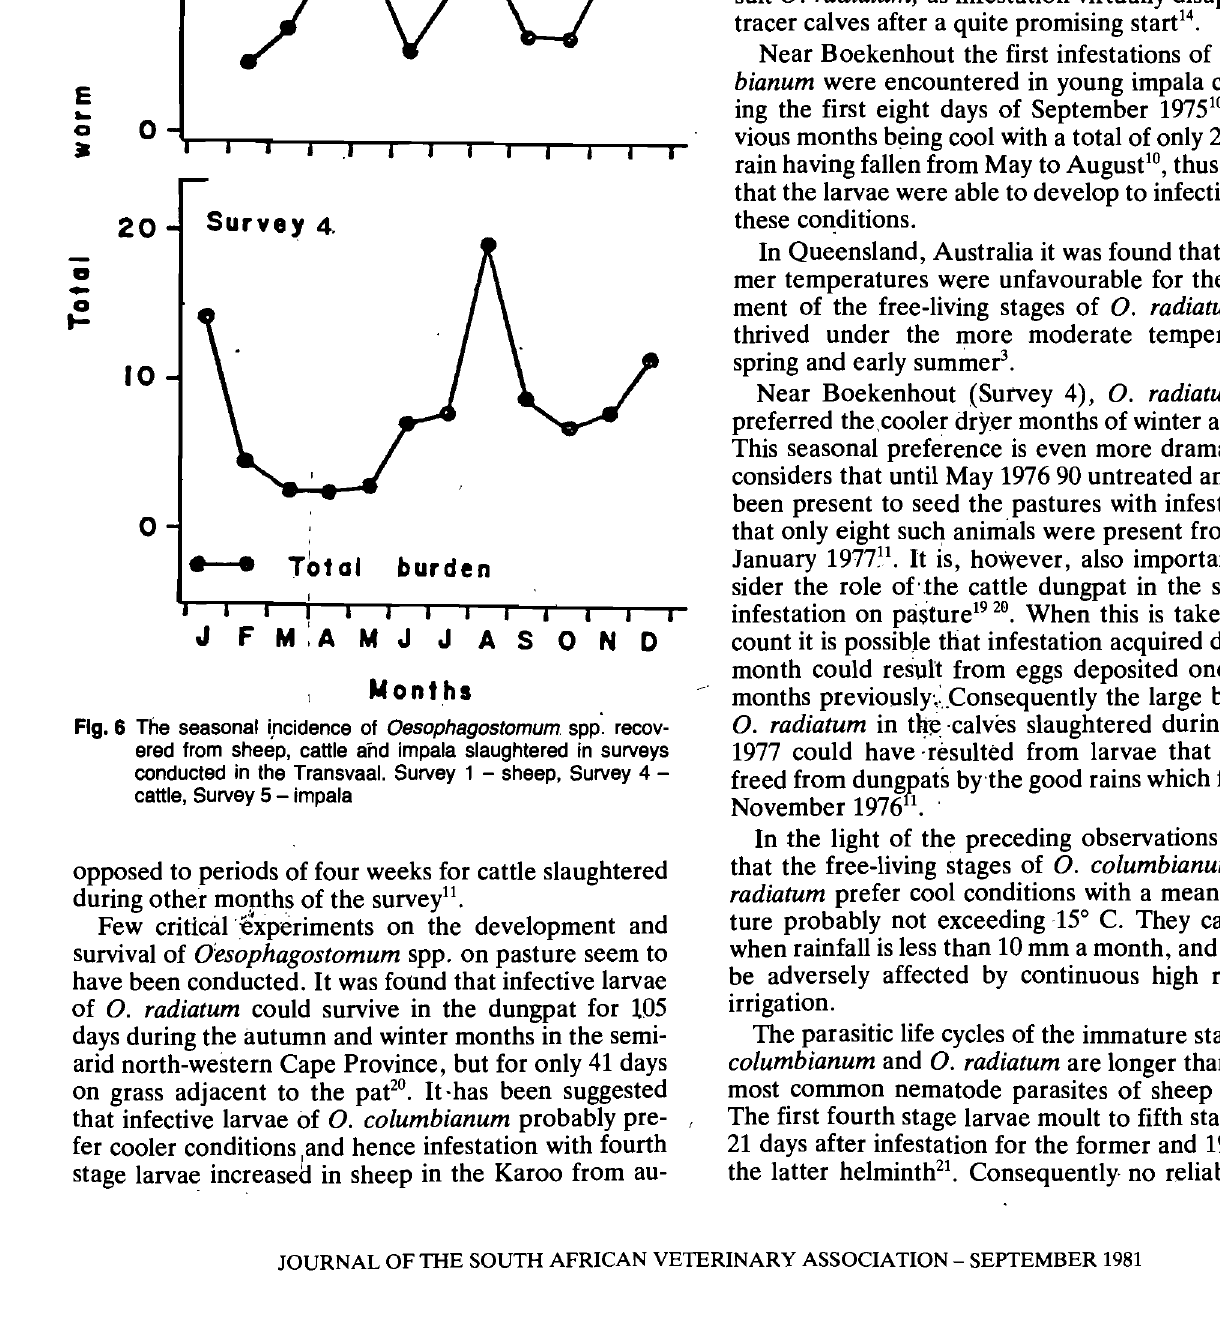
Fig. 6 The seasonal i,ncidence of Oesophagostomum spp: recov ered from sheep, cattle and impala slaughtered in surveys conducted in the Transvaal. Survey 1 - sheep, Survey 4 - cattle, Survey 5 - impala